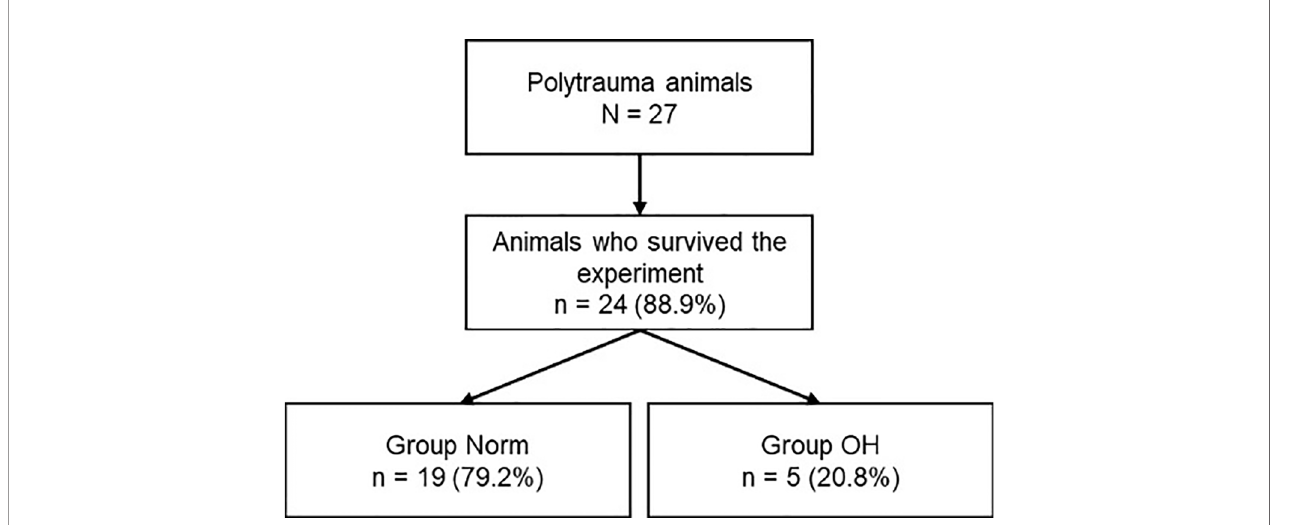
FIGURE 1 | Flowchart and strati fi cation according to occult hypoperfusion (OH) as de fi ned by persistent elevated lactate levels despite responding vital parameters following